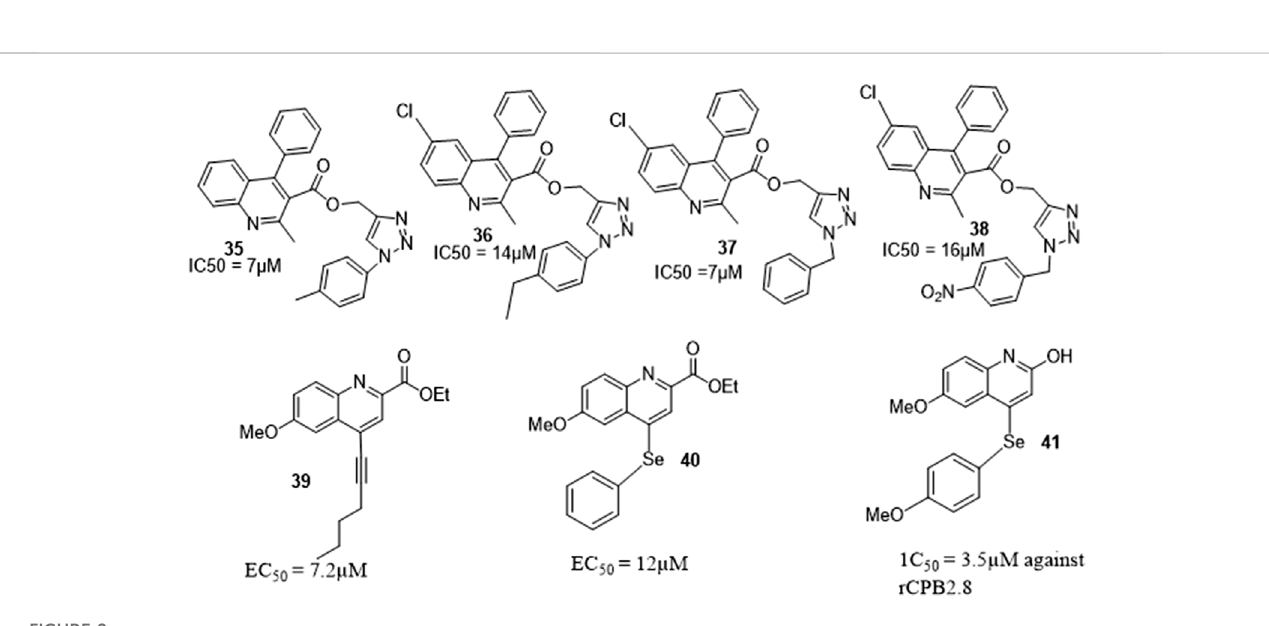
FIGURE 8 Quinoline hybrids with antileishmanial